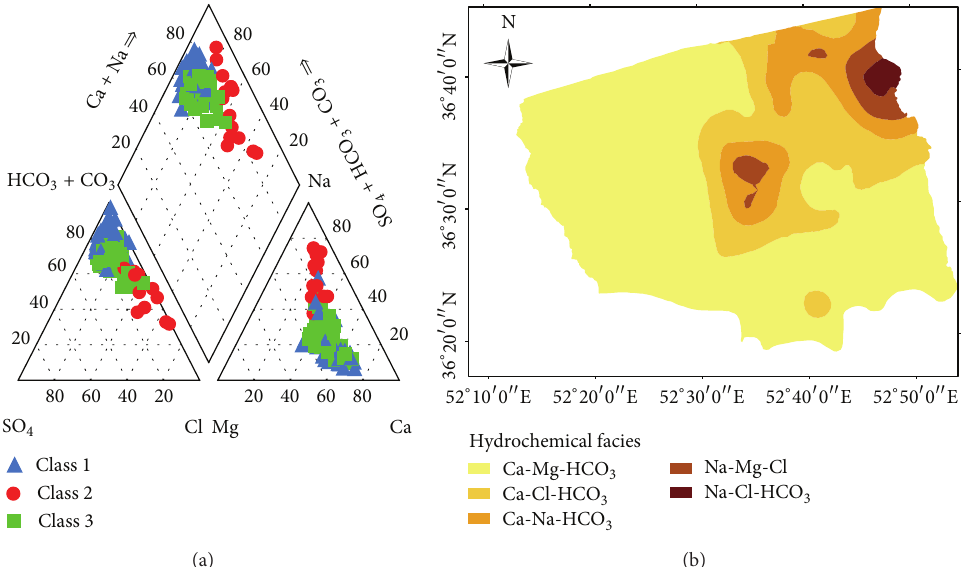
Figure 4: (a) Piper diagram presentation for groundwater constituents. (b) Spatial distribution of water type in the groundwater of the study